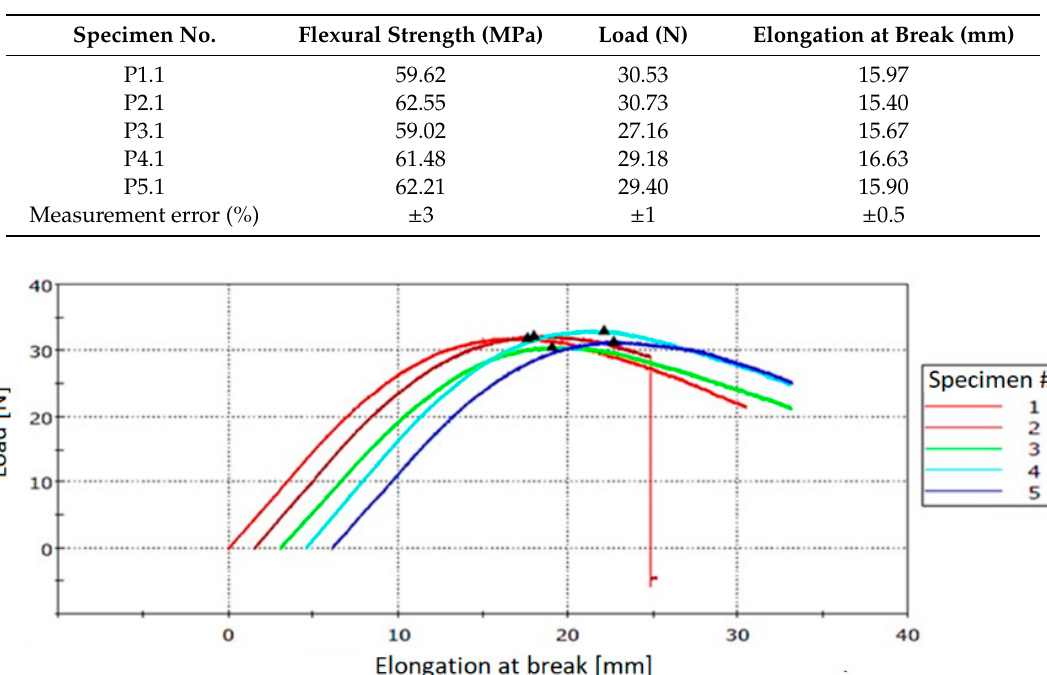
Figure 23. Stress–strain curves for specimens cured at 60 °C for 16 h.